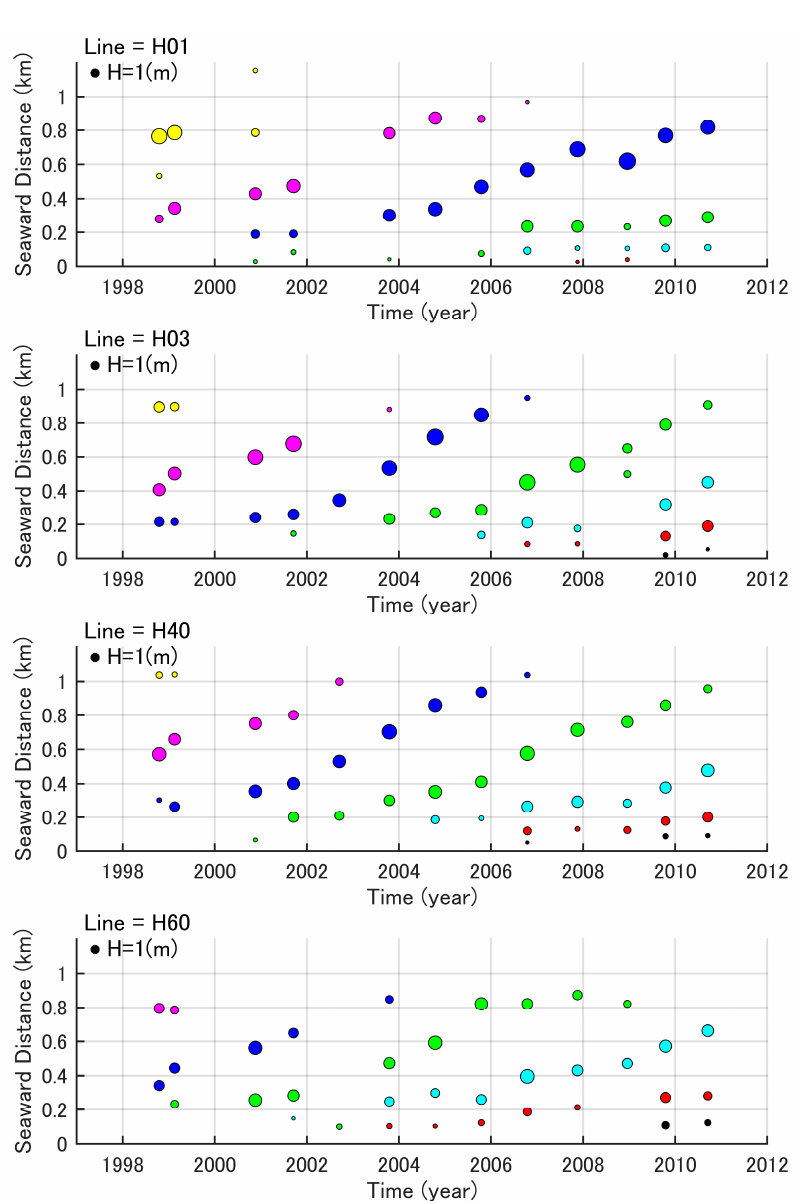
Figure 13. Cross ‐ shore migration of bars on each transect. Figure 13. Cross-shore migration of bars on each transect.